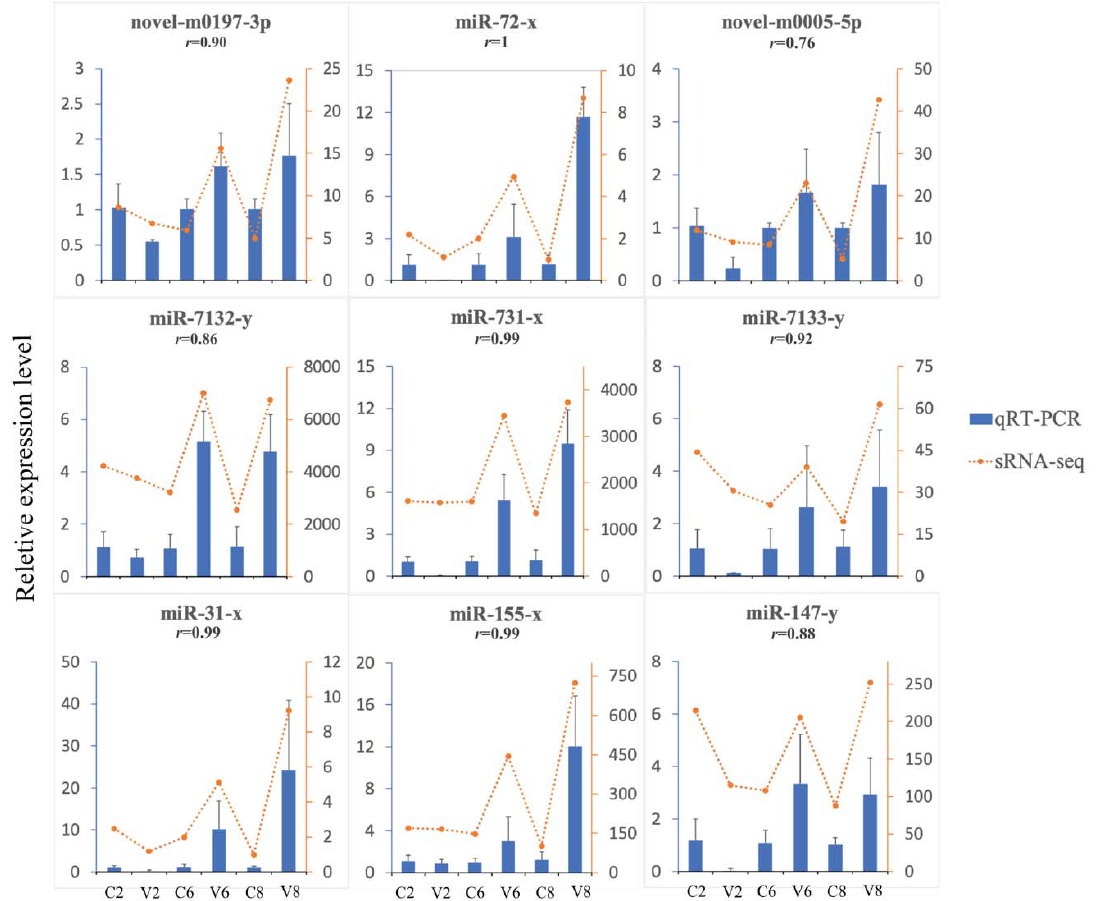
Figure 3. Validation of the small RNA-seq data by quantitative real-time PCR (qRT-PCR). The relative expression profiles of 9 DEmiRs, at 2, 6, or 8 days post infection, detected by qRT-PCR (bars) and compared with the results of RNA-seq (dotted lines). Error bars represent standard deviations. For each DEmiR, the correlation coefficient (r) between the results of qRT-PCR and sRNA-seq is shown.